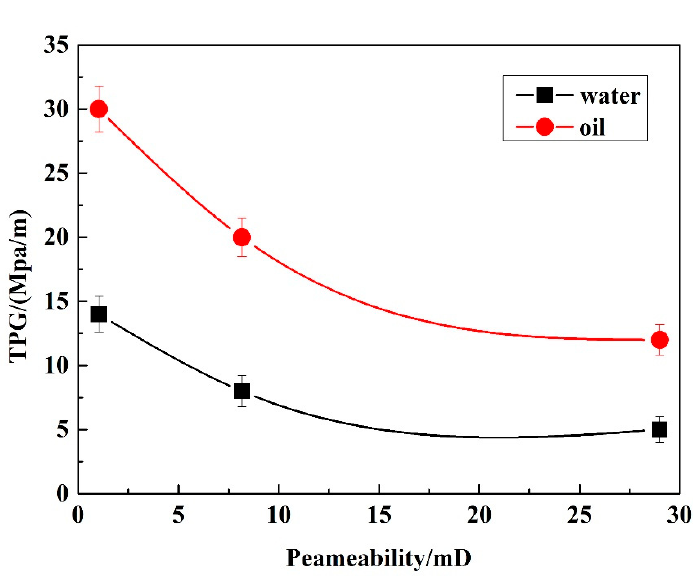
Figure 2. The TPG versus permeability of water and oil.